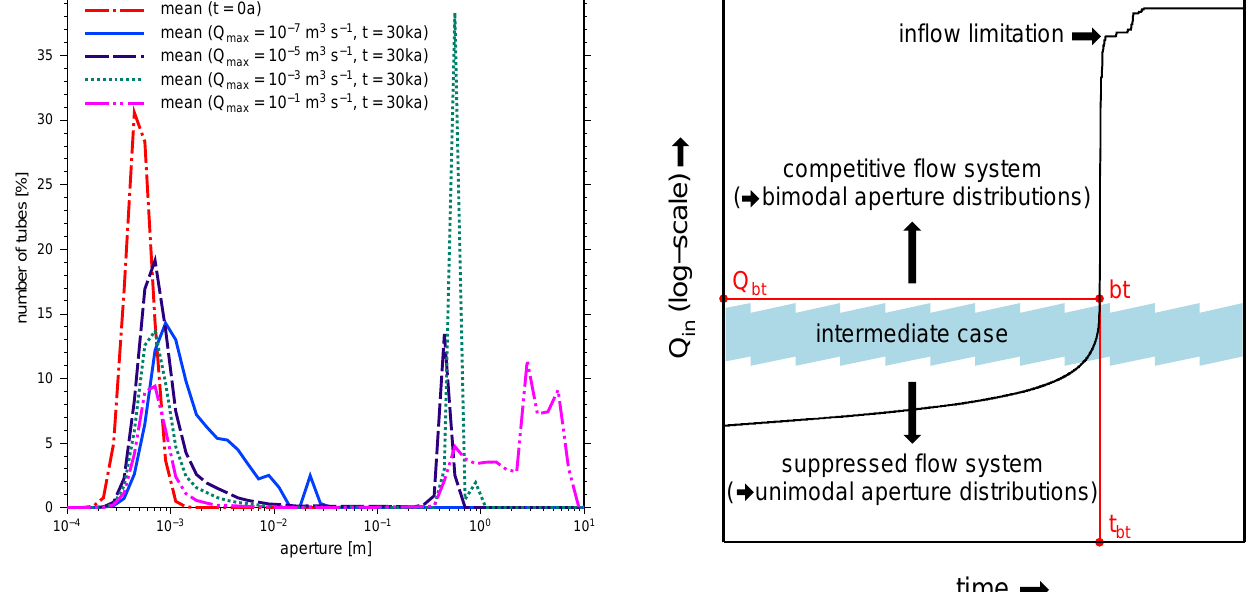
Fig. 5. Schematic development of the total inflow rate Q in in time. The time (t bt ) and flow rate (Q bt ) at breakthrough (bt) are shown. If Q in is restricted to ≈ Q bt or higher, competitive flow systems establish and bimodal aperture distributions develop. In suppressed flow systems the total flow rate is limited to some lower value and lead to unimodal aperture distributions at mature stages. Intermediate cases must be